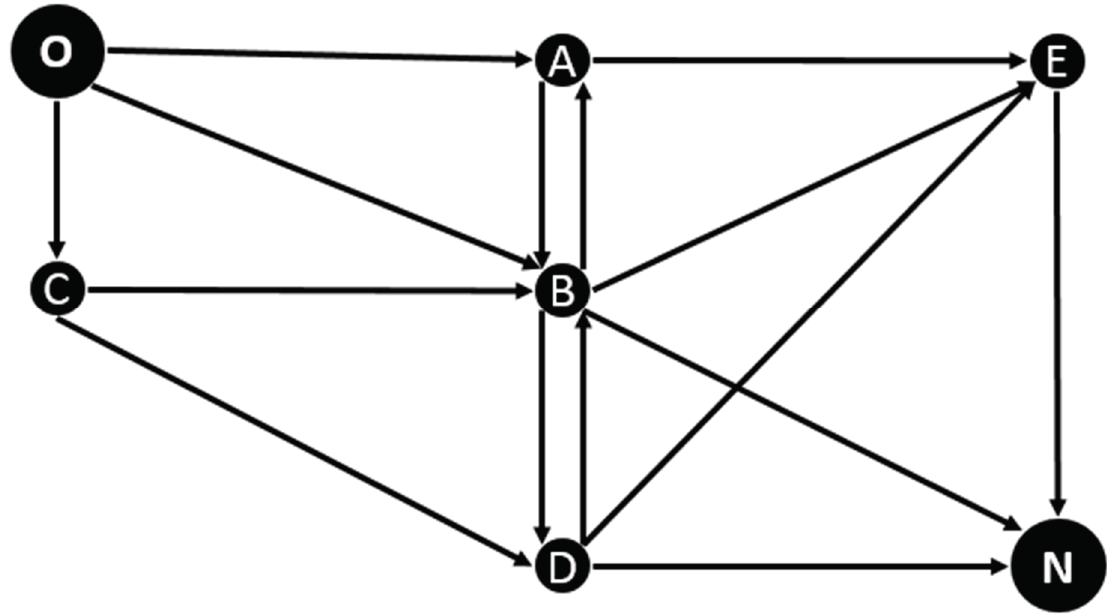
Figure 16. Proposed control